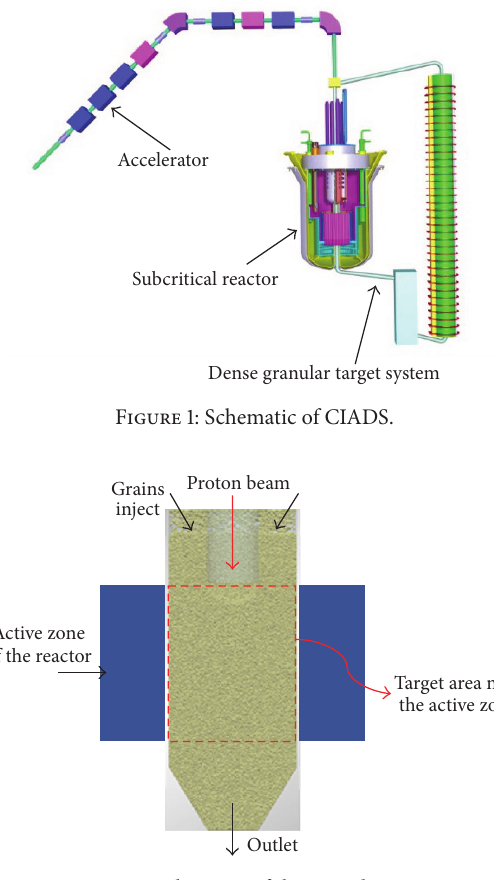
Figure 2: Schematic of the granular target.